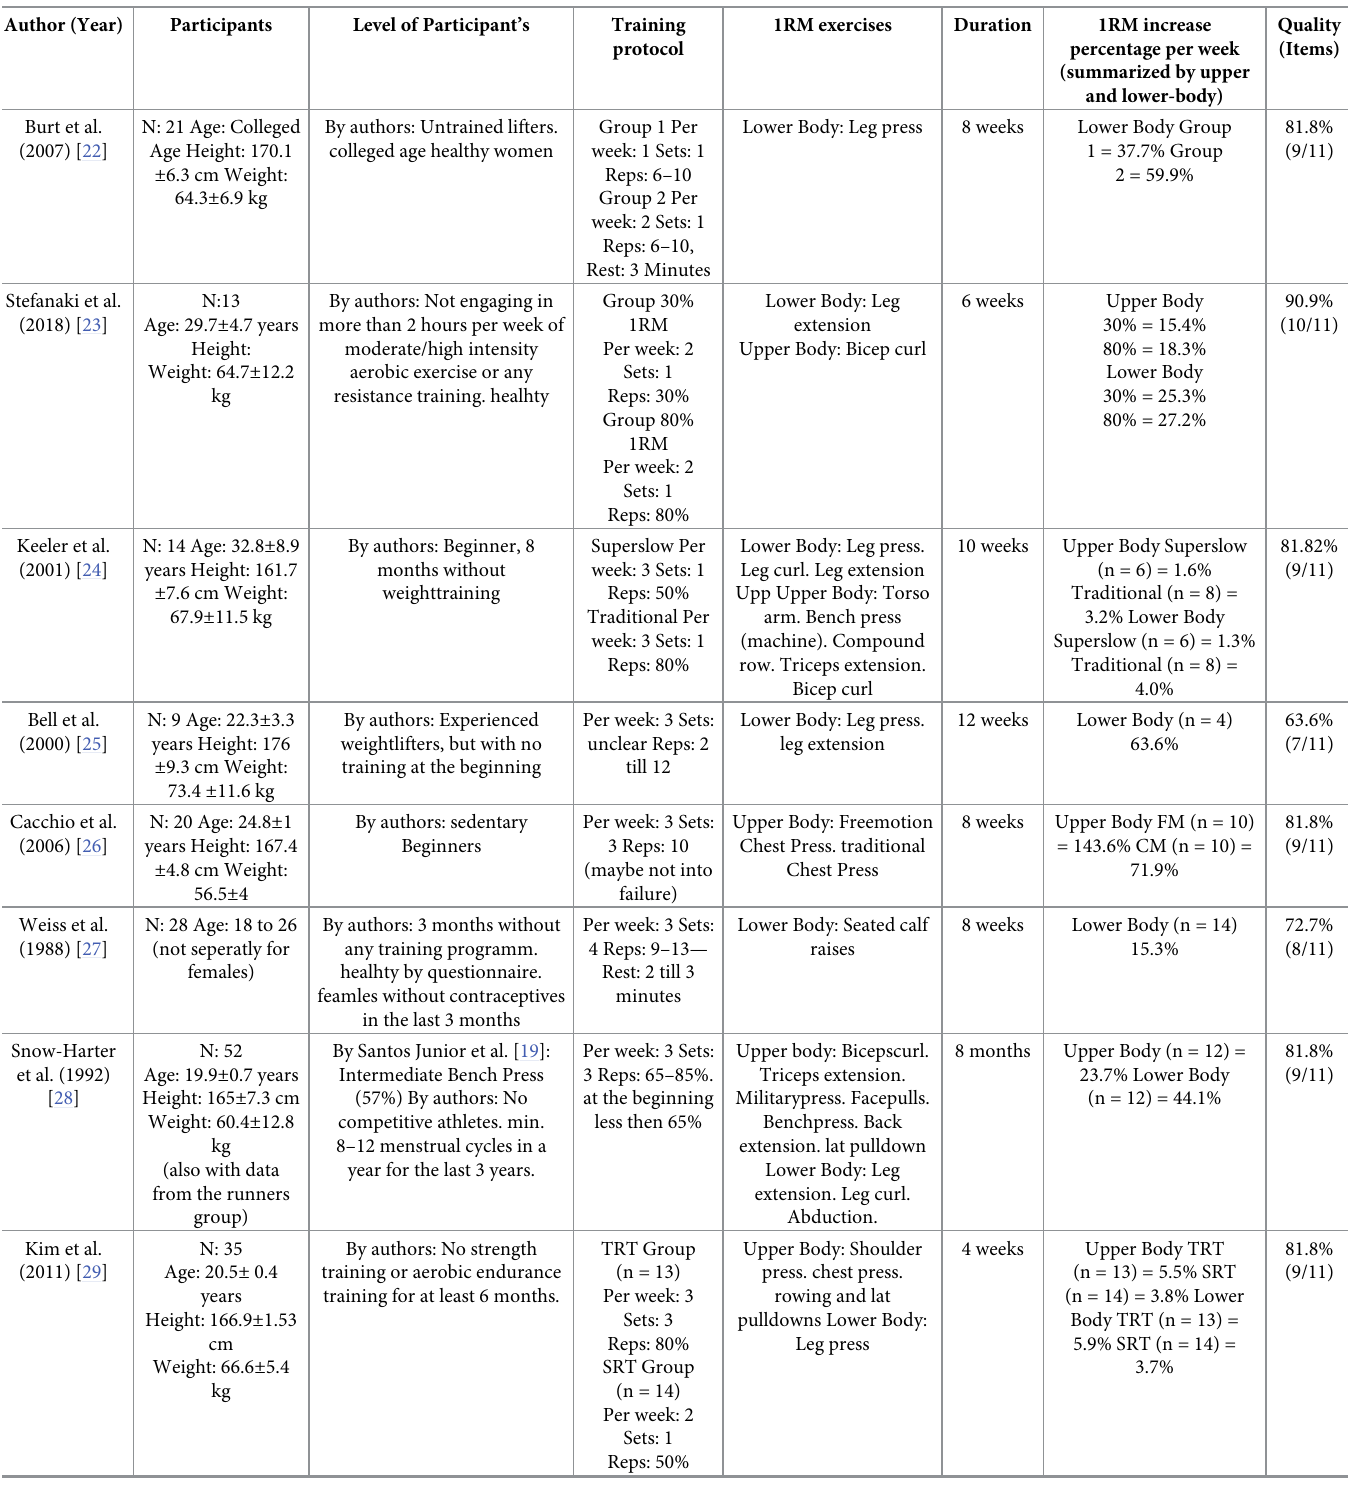
Table 2. Summary of all included studies for the final